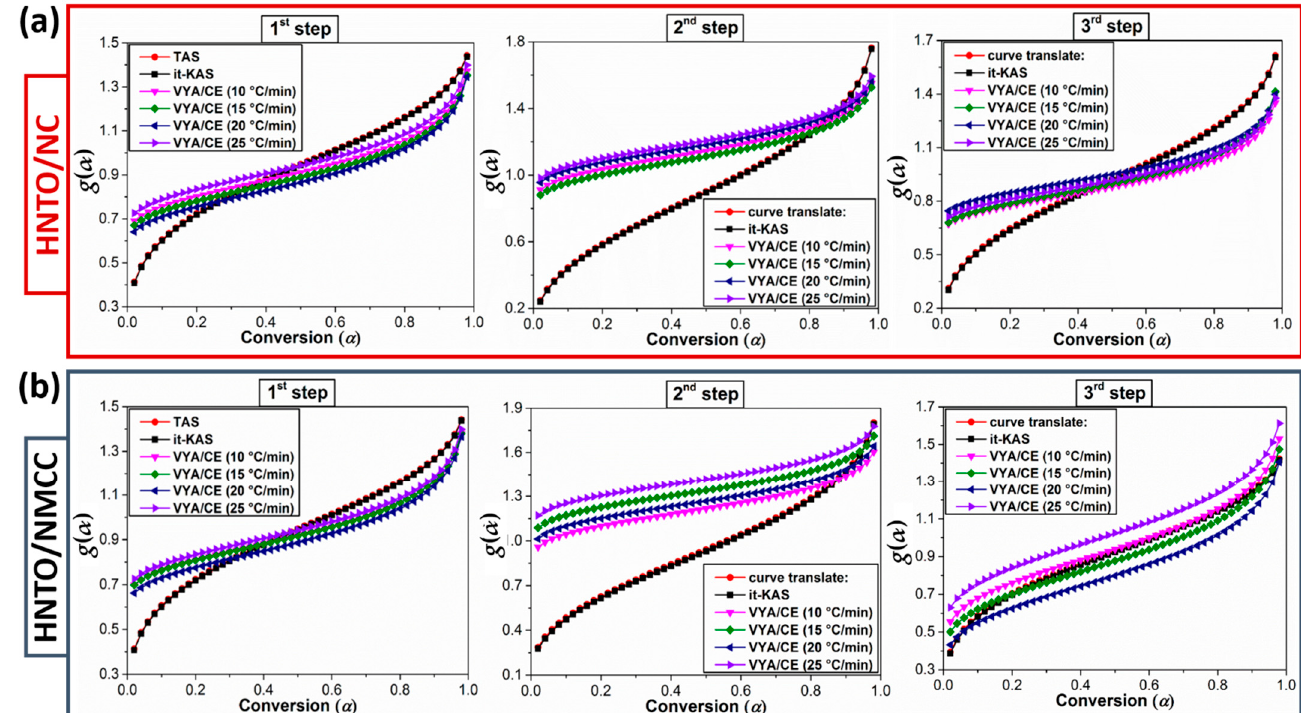
Figure 7. Variation of the integral reaction model versus the extent of conversion for each decom- position step of ( a ) HNTO/NC composite; ( b ) HNTO/NMCC